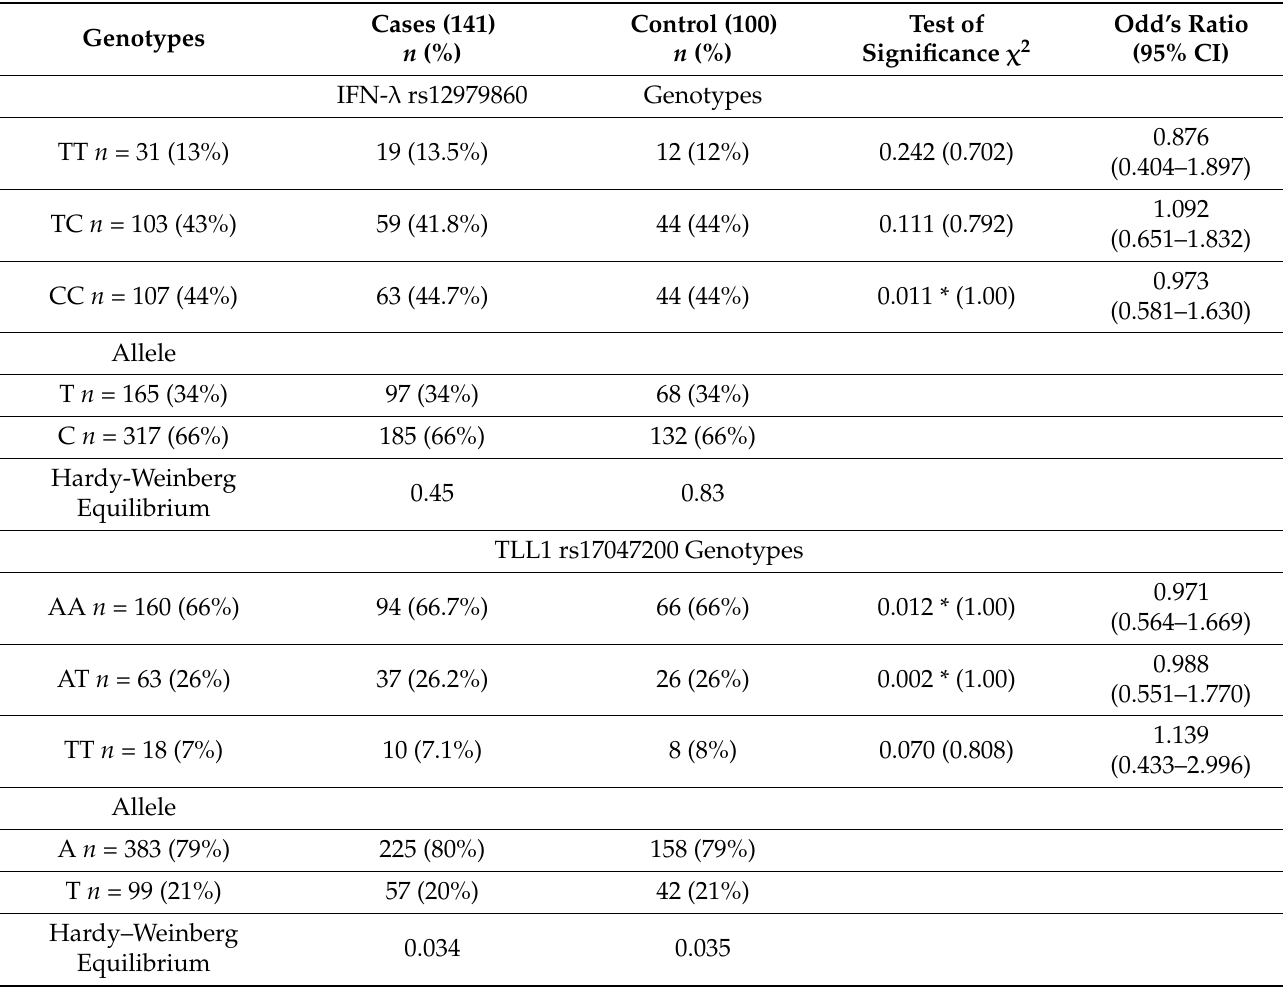
Table 2. Genotype frequencies between the studied